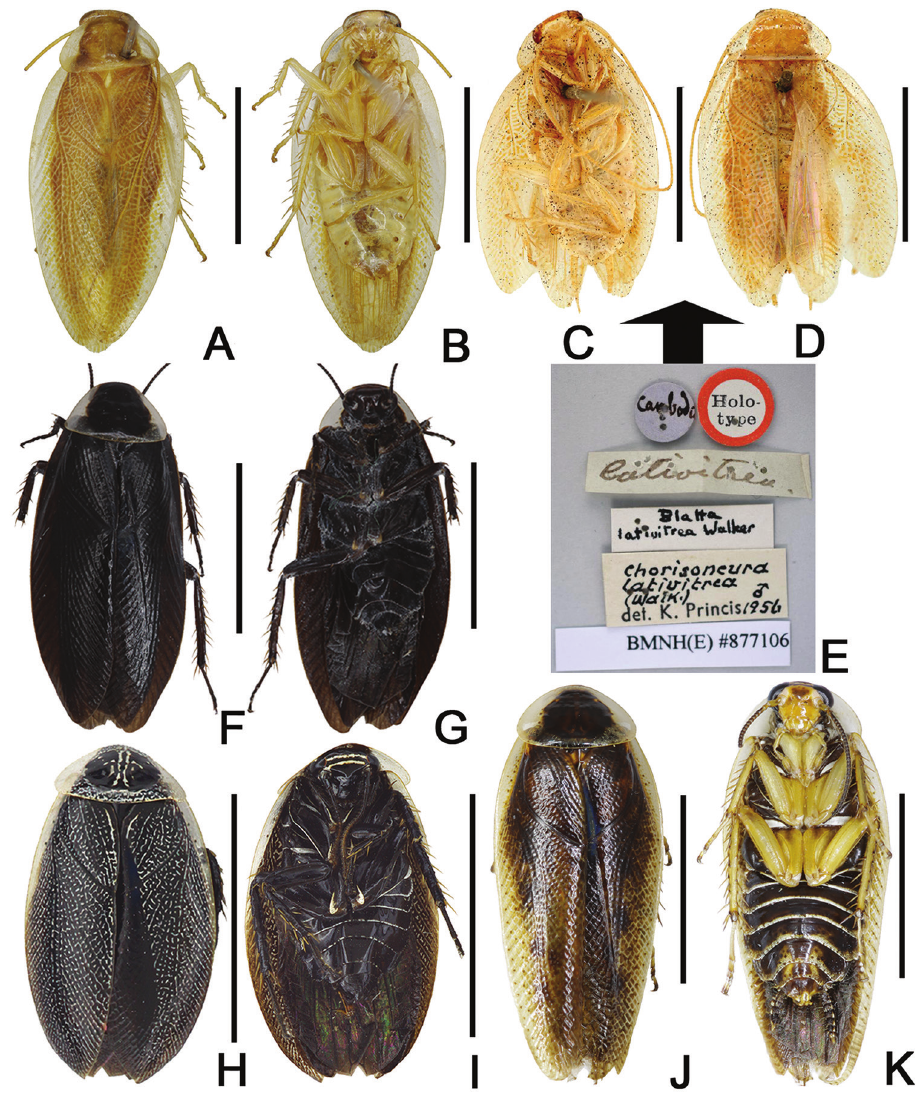
Figure 11. Habitus. A, B S. formosana (Matsumura, 1913) male from China, Hainan, Ledong, Mt. Ji- anfengling, 1050m, dorsal and ventral views C, D, E (labels) S. lativitrea (Walker, 1868) (to compare with S. formosana ) holotype (copyright Natural History Museum, London), dorsal and ventral views F, G S. nigra (Shiraki, 1908) male from China, Hubei, Mt. Dabieshan, Taohuachong, dorsal and ventral views H, I S. shanensis (Princis, 1950) male from China, Yunnan, Lincang, Nansan, dorsal and ventral views J, K S. undulata (Bey-Bienko, 1958) male from China, Yunnan, Xishuangbanna, Wangtianshu, dorsal and ventral view. Scale bars: 5